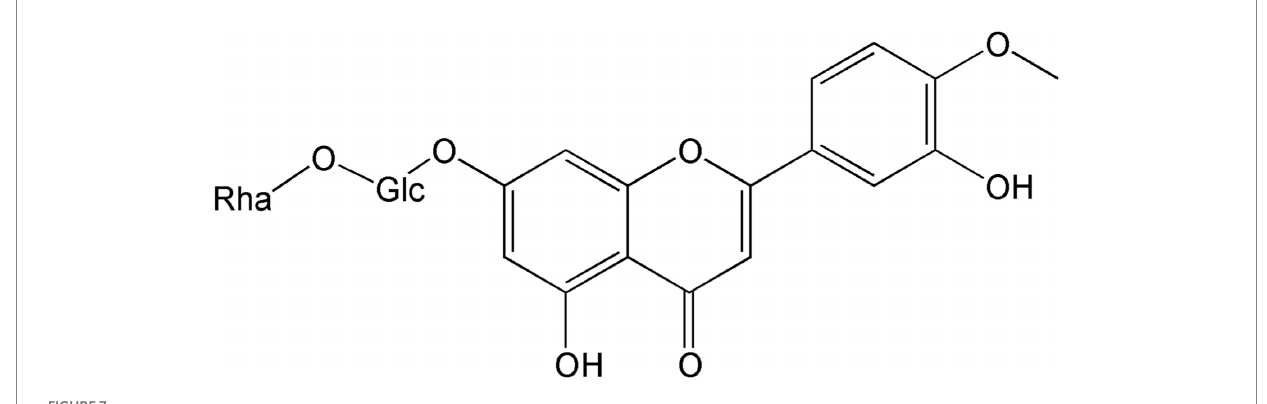
FIGURE 7 Chemical structure of diosmin-2.